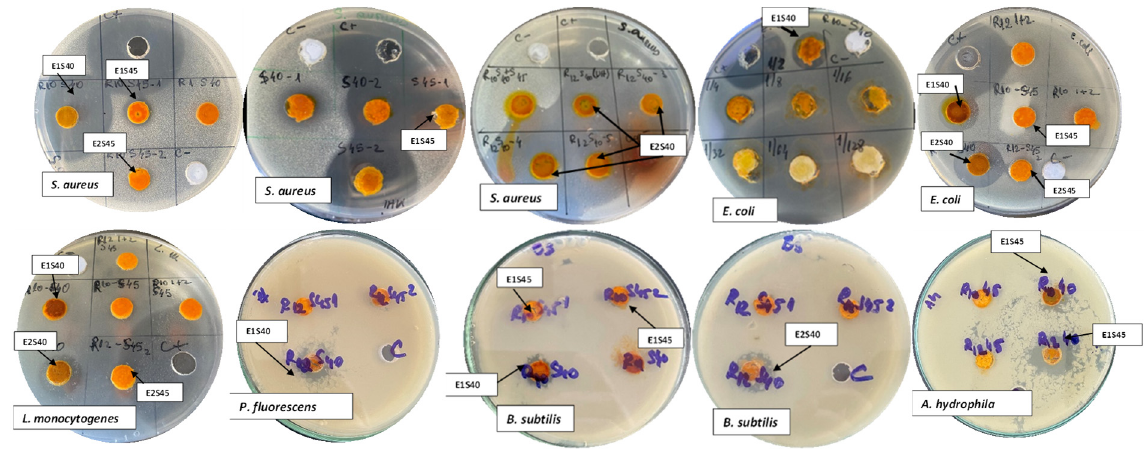
Figure 3. Zones of inhibition of SFE-CO 2 extracts against various bacterial strains.